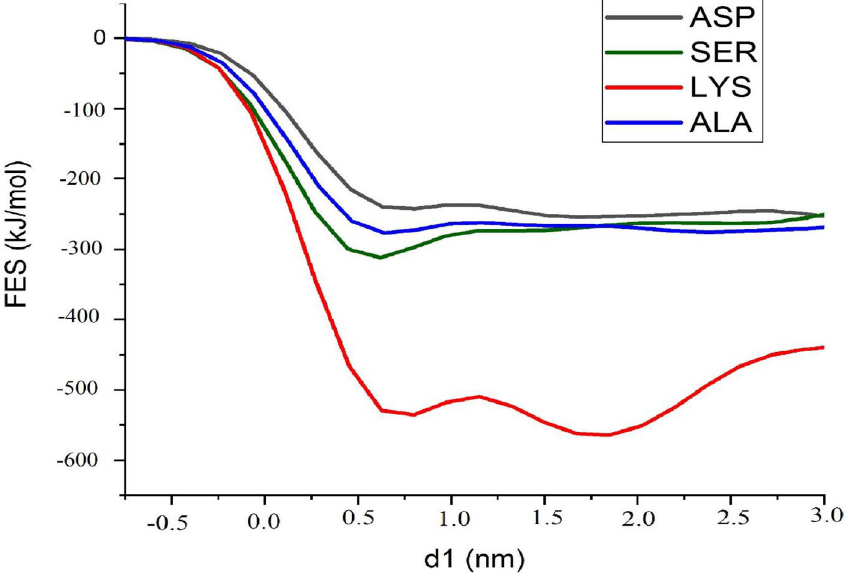
Figure 9. The free energy profile for the different adsorption of amino acids on the BNNS surface as a function of the center of mass of the molecules from the carrier.